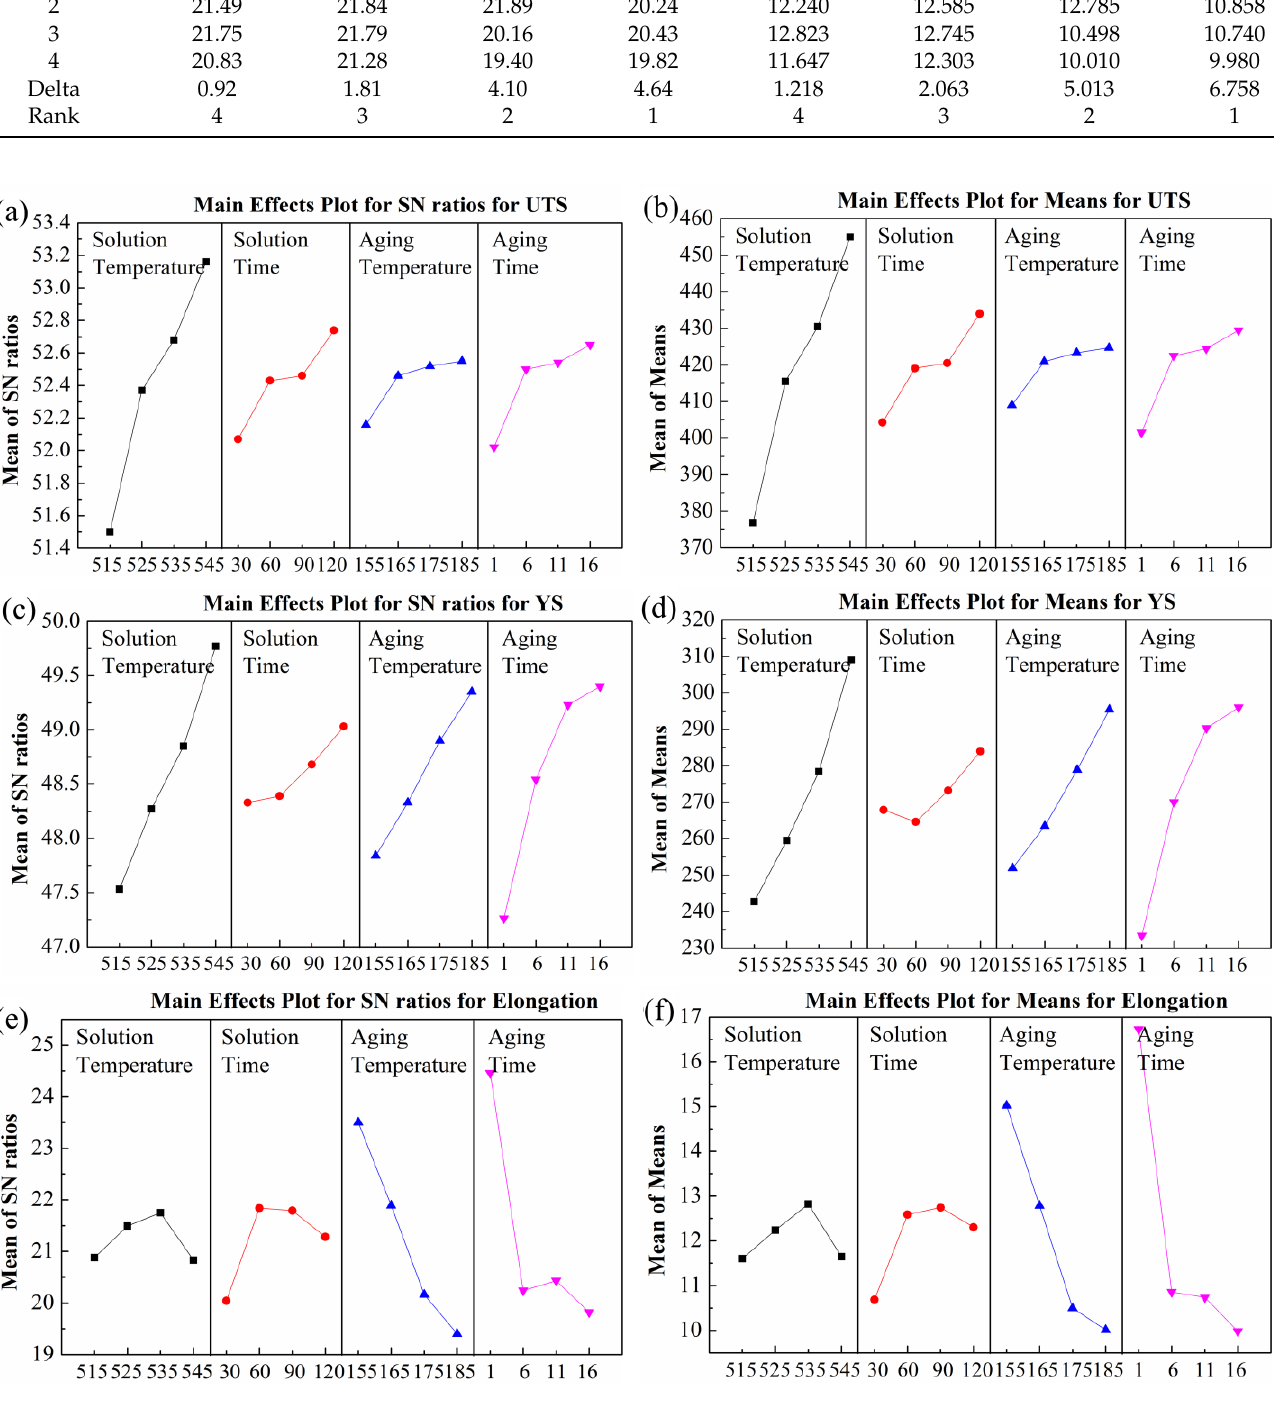
Figure 3. ( a ) The micro hardness distribution and ( b ) tensile properties for the as-deposited and heat-treated WAAM 2219 alloy.